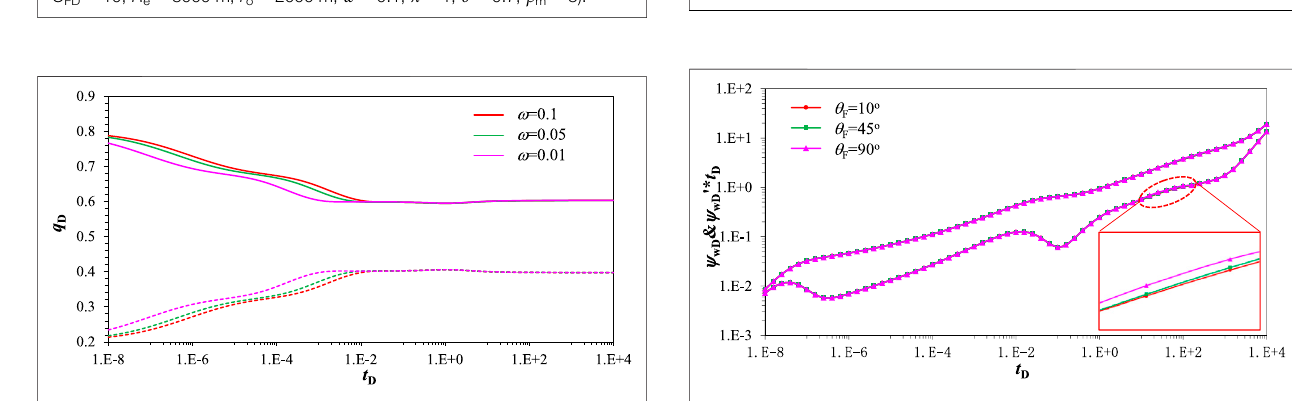
Figure 15 is a pressure transient response curve in fl uenced by fracture angle. The in fl uence of fracture angle on the pressure derivative curve is not very obvious. The fracture angle physical model is shown in Figure 16 . The blue is the hydraulic and the red circle is the wellbore. Since fl uid cannot fl ow into the hydraulic fracture and the largest rate supplement of the hydraulic fracture comes from fracture surface, the pressure